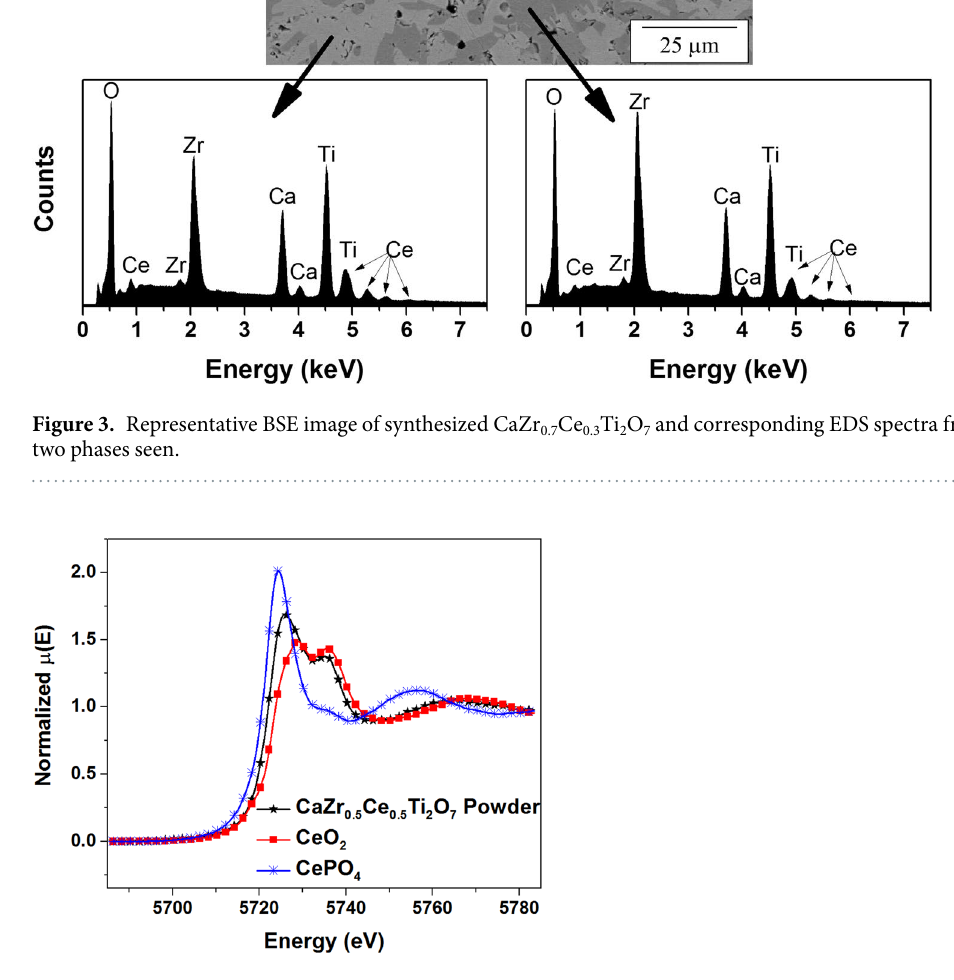
Figure 4. XANES results from standard materials and synthesized Ce-zirconolite powder.